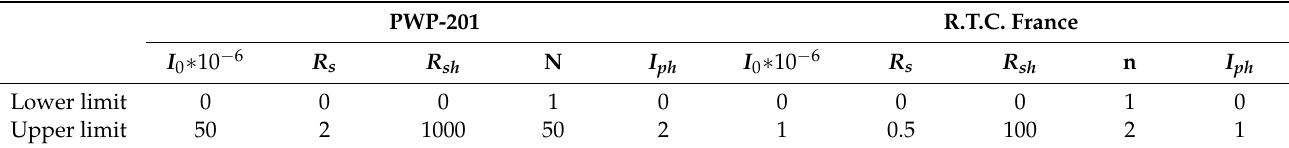
Table 2. Parameter